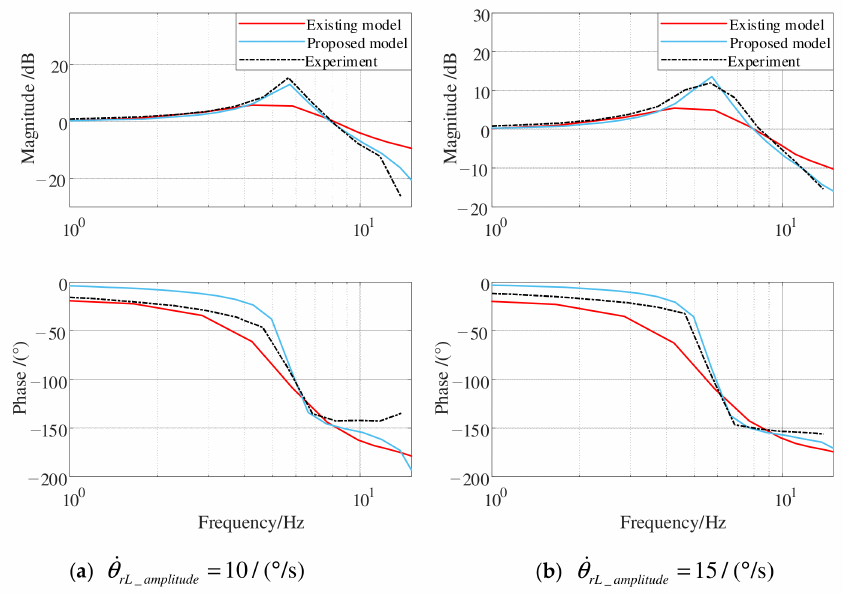
Figure 19. Simulated and experimental frequency responses under a